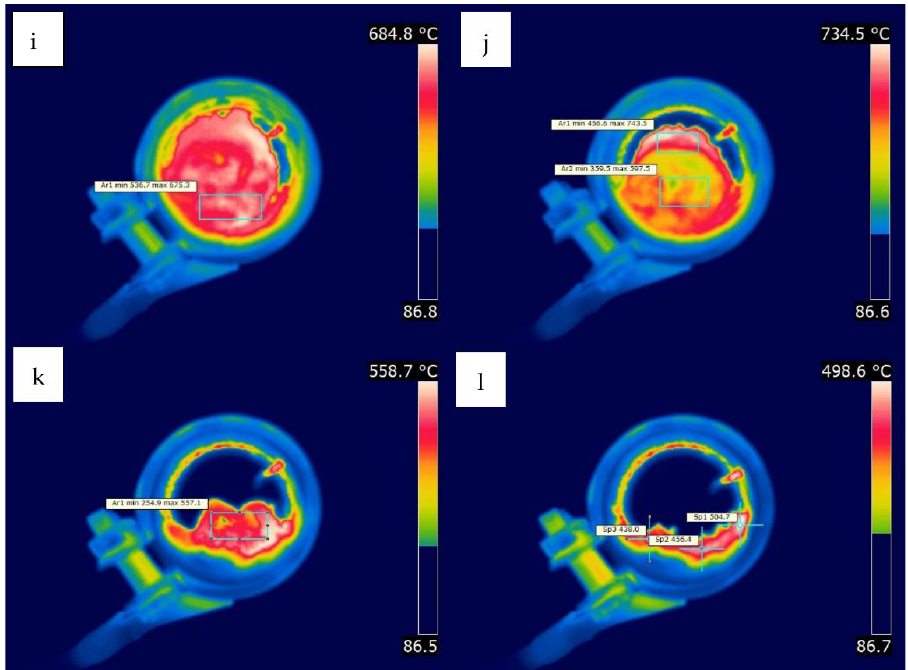
Figure 4. Thermograms of 50K50J sample combustion, ( a ) ignition of external part of the material, ( b – g ) progressive process of drying the material and fuel degassing, ( h – j ) char ashing, ( k – l ) ash formation.